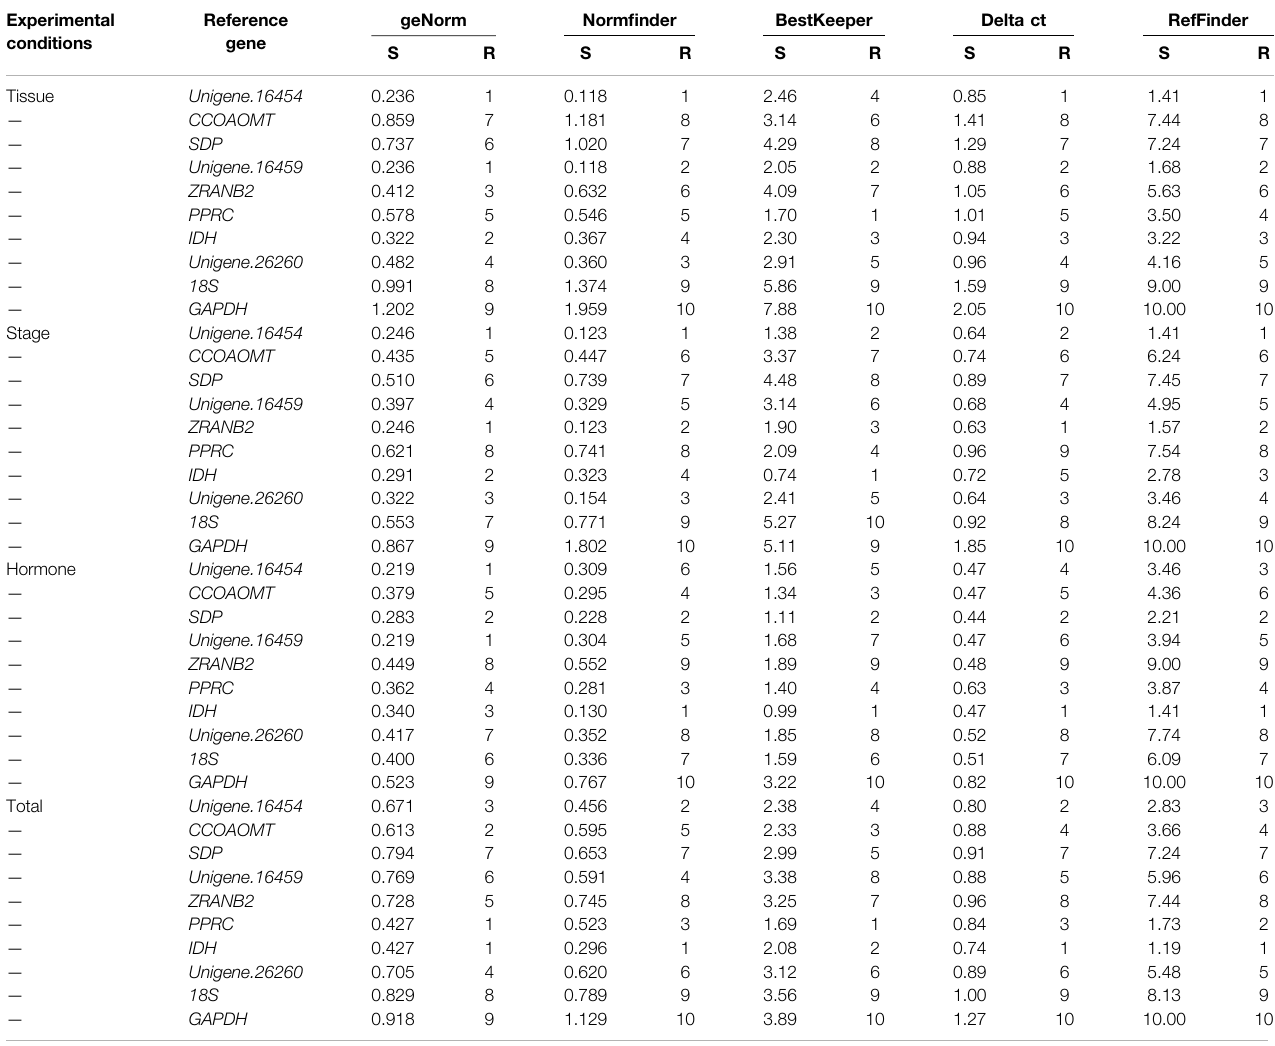
Tissue represents samples from different tissues. Stage represents samples from chimeric leaves at different developmental stages. Hormone represents samples from tissue culture plantlet under different hormone treatments. Total represents samples from the above three experimental conditions. S and R represent the stability values and rank of each method,